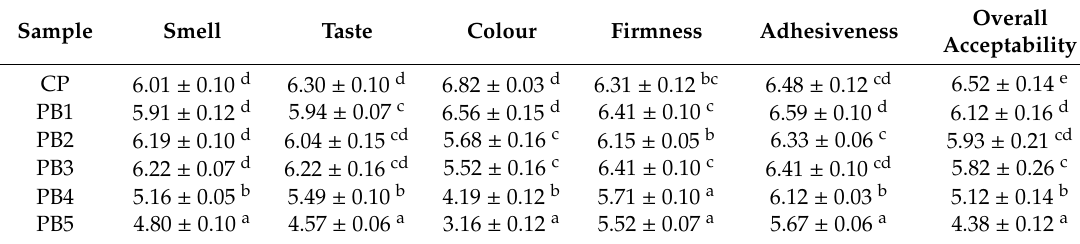
Table 7. Results of cooked pasta sensory